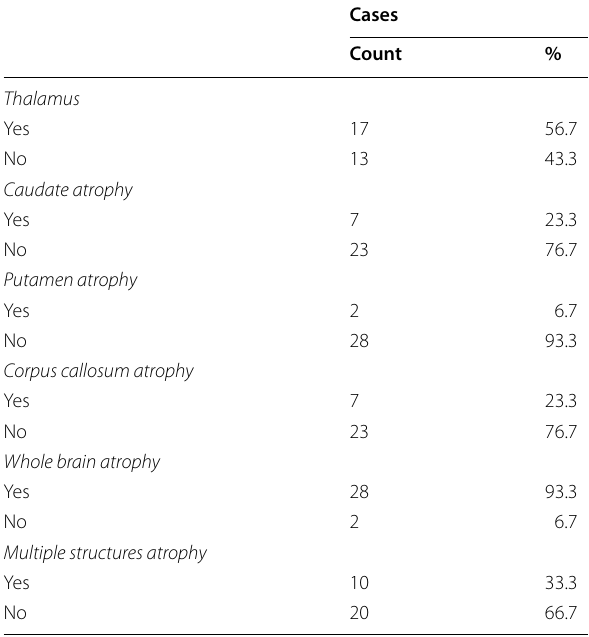
Table 6 Number and percent of patients with and without thalamic, whole brain, caudate, putamen, corpus callosum and multiple structures atrophy